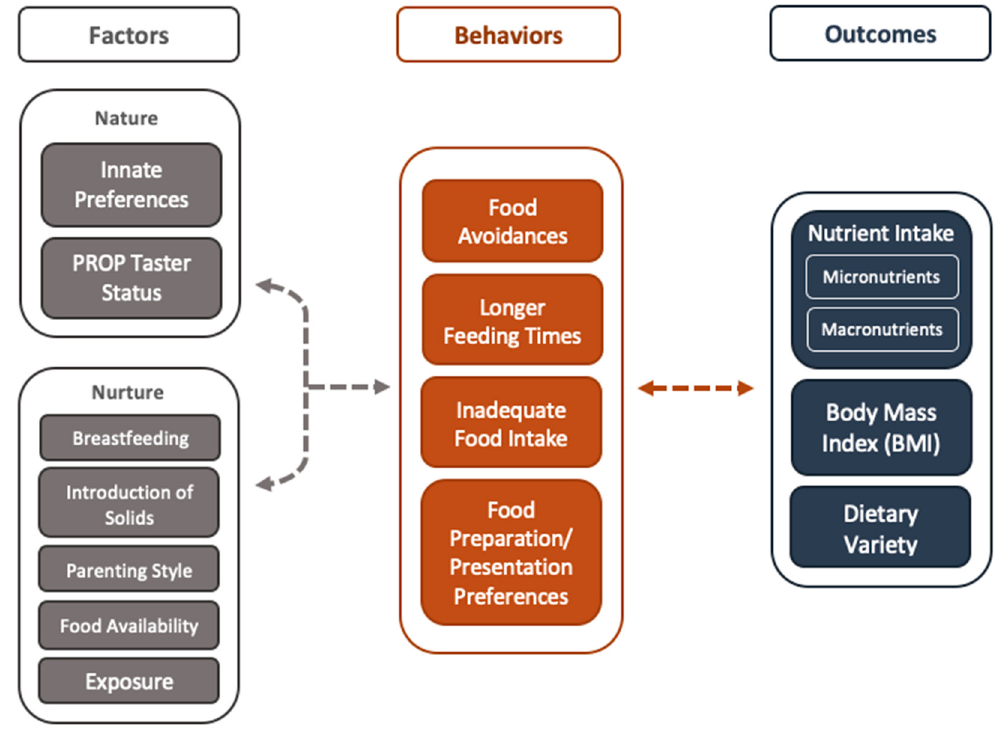
Figure 1. Concept flow diagram illustrating genetically determined (nature) and environmental (nurture) factors affecting child picky eating behaviors as observed by caregivers and their developmental outcomes.